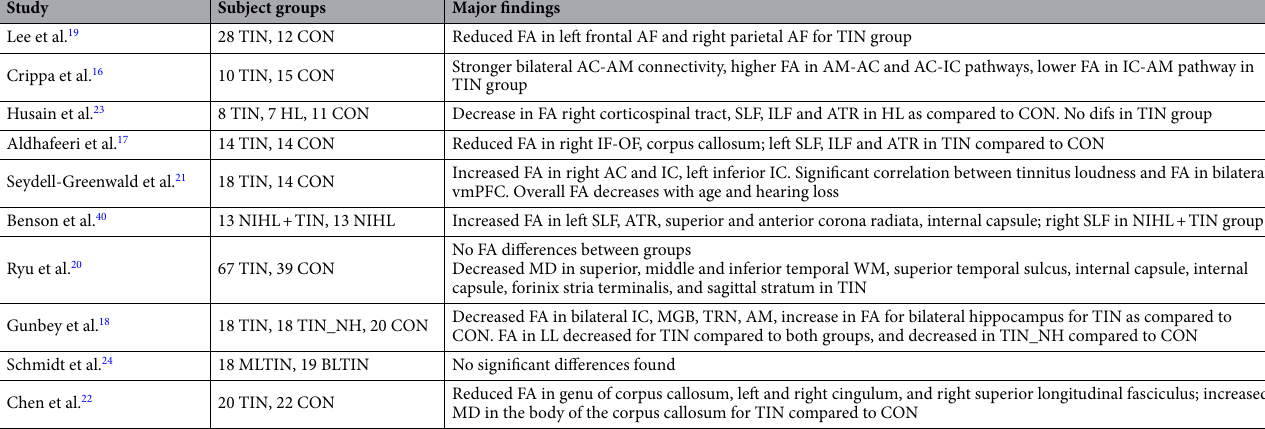
Table 1. Summary of findings from previous DTI studies of tinnitus. TIN tinnitus group, CON normal- hearing controls, HL hearing loss controls, NIHL noise-induced hearing loss, TIN_NH tinnitus with normal hearing, MLTIN mild, long-term tinnitus, BLTIN bothersome long-term tinnitus, FA fractional anistropy, MD mean diffusivity, AC auditory cortex, IC inferior colliculus, AM amygdala, AF arcuate fasciculus, IF-OF inferior fronto-occipital fasciculus, SLF superior longitudinal fasciculus, ILF inferior longitudinal fasciculus, ATR anterior thalamic radiation, vmPFC ventromedial prefrontal cortex, MGB medial geniculate body, TRN thalamic reticular nucleus, LL lateral